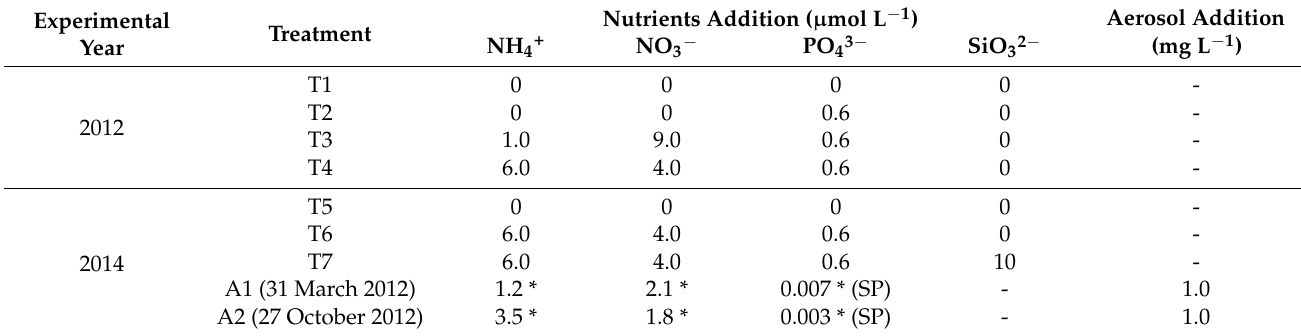
Table 1. The concentrations of nutrients and amounts of aerosols added to different treatments of the bioassay experiments conducted in 2012 and 2014. Chemicals, (NH 4 ) 2 SO 4 , NaNO 3 , NaH 2 PO 4 · 2H 2 O, and Na 2 SiO 3 · 9H 2 O and aerosols sampled at Huaniao Island were used for